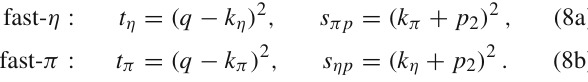
Fig. 4 Integrated forward F ( m ) (green), backward B ( m ) (red), and total T ( m ) = F ( m ) + B ( m ) (blue) intensities as defined in Eq. (5) for the MVR (full circles) and MCR (empty squares). Uncertainties in the MVR are taken from the MCR. We note that the slope of F ( m ) for both ηπ and η (cid:2) π is steepper than for B ( m )